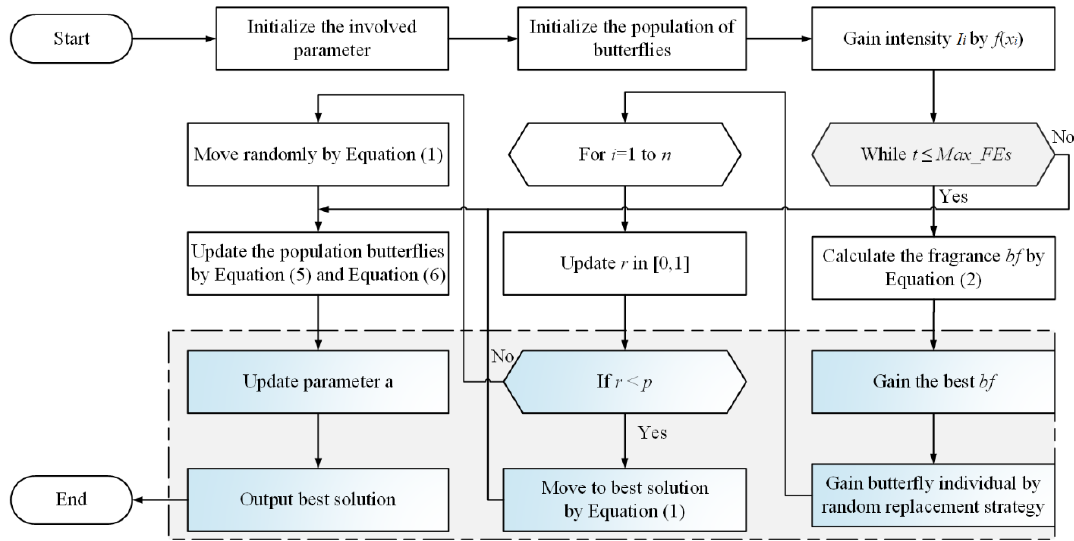
Figure 1. The flowchart of the RCCBOA.